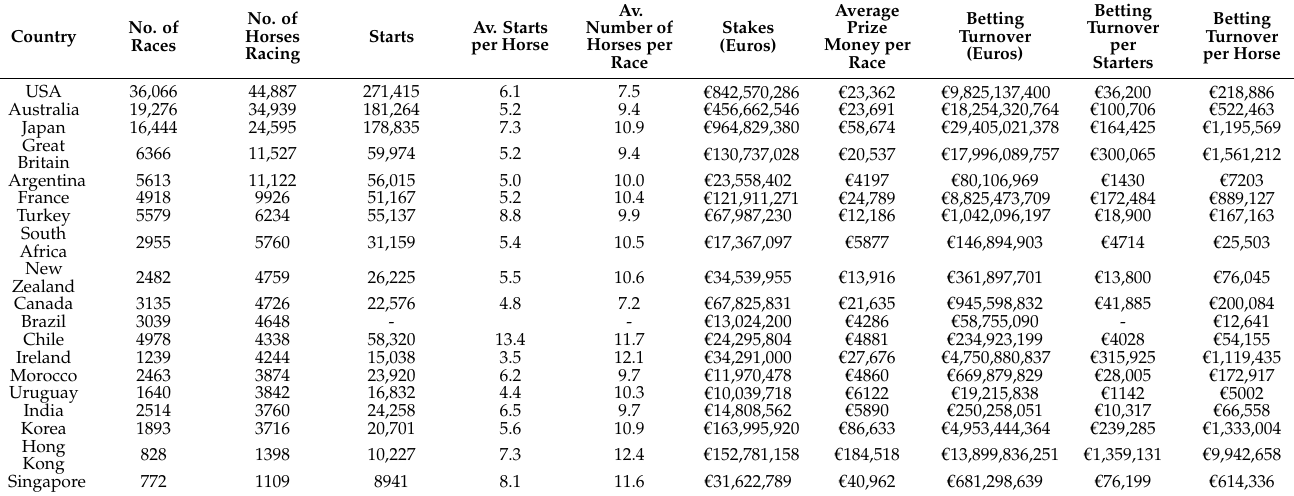
Table 1. Summary data of racing and economic return levels for the major racing nations in 2019. Source: International Federation of Horse Racing Authorities